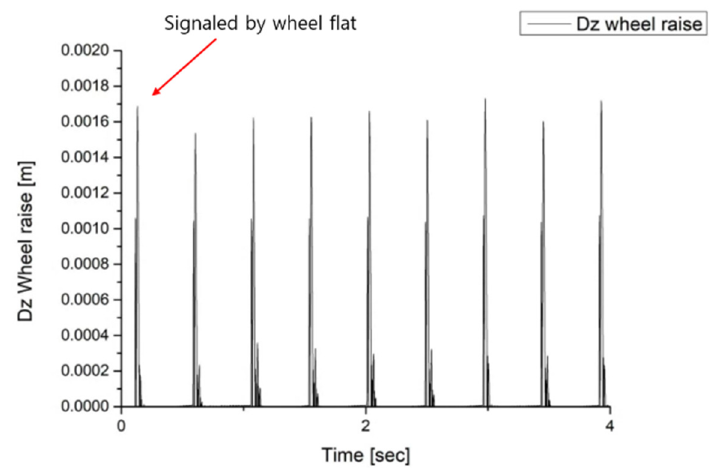
Figure 8. Dz-Wheel raised in the SIMPACK post result.